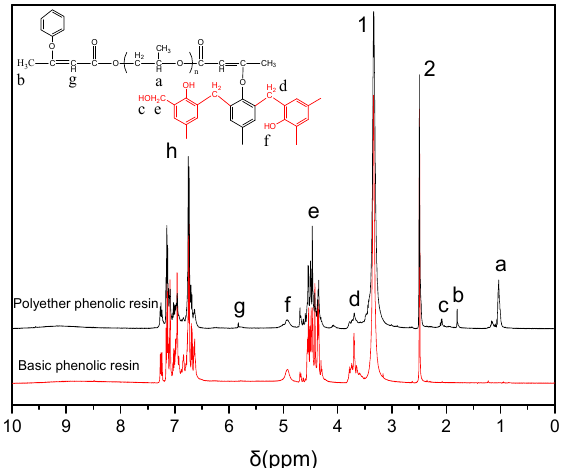
Figure 2. The 1 H nuclear magnetic resonance (NMR) spectra of the basic phenolic resin and polyether phenolic resin (the amount of acetoacetic ester-terminated polyether is 16% of the amount of phenol).